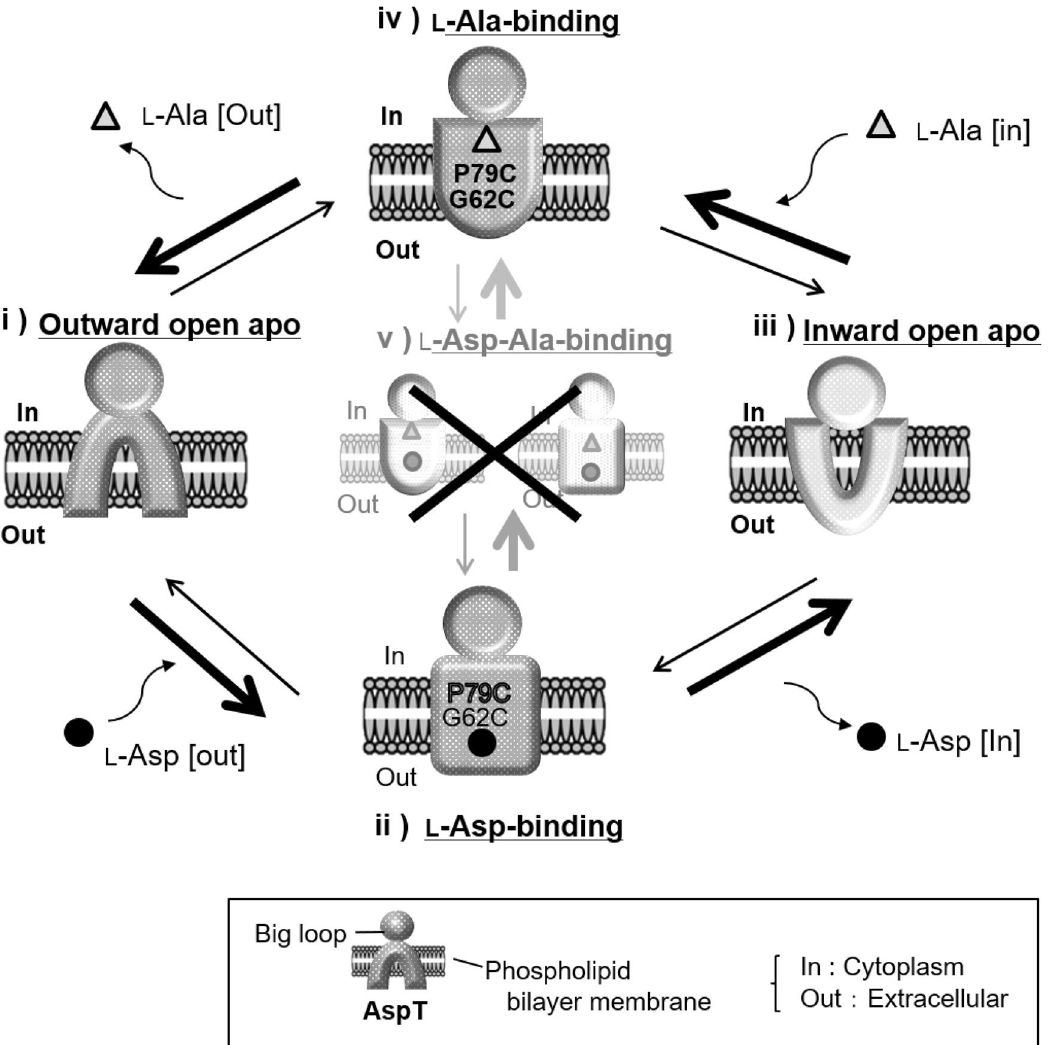
Figure 6. Schematic representation of the AspT substrate transport cycle. Upper is a schematic representation of the l-Ala self-exchange reaction, and Lower is a l-Asp self-exchange reaction. The outward open apo conformation changes its conformation to the l-Asp-bound conformation (ii) by an induced-fit mechanism upon binding of extracellular l-Asp (black circles; ● ), and it transports l-Asp into the cell. Then AspT binds intracellular l-Ala (gray triangles; ▲ ), changes its conformation to an l-Ala-bound conformation by